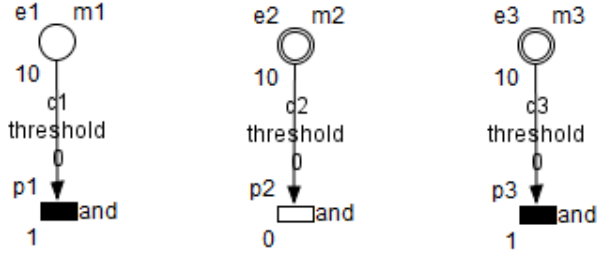
Figure 5. Different combination representing degradation in metabolic pathways. (discrete entity, discrete process), (continuous entity, continuous process), and (continuous entity, discrete process).